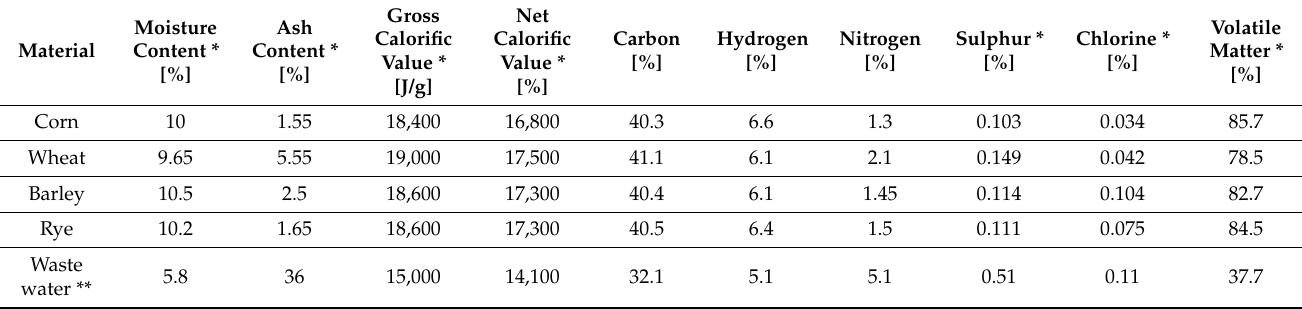
Table 1. Elemental composition of analyzed substrates for biogas